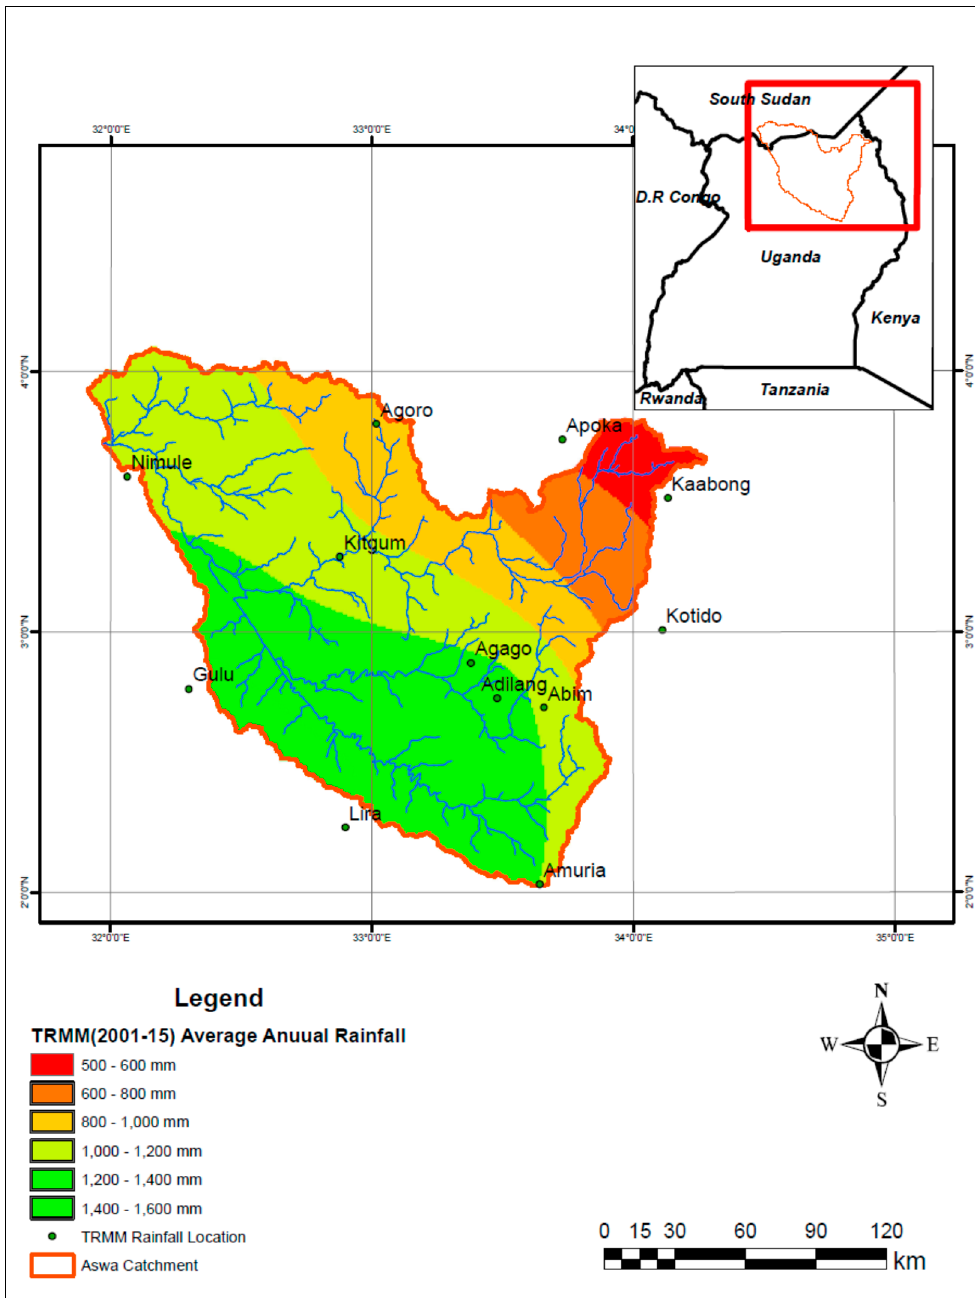
Figure 1. Location of Aswa River catchment and GIS generated average Tropical Rainfall Measuring Mission (TRMM) annual rainfall (2000–2015)